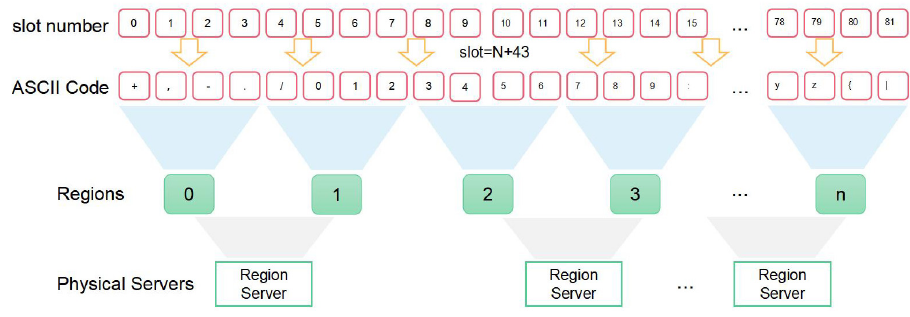
Figure 5. Scalable storage architecture for tile data.